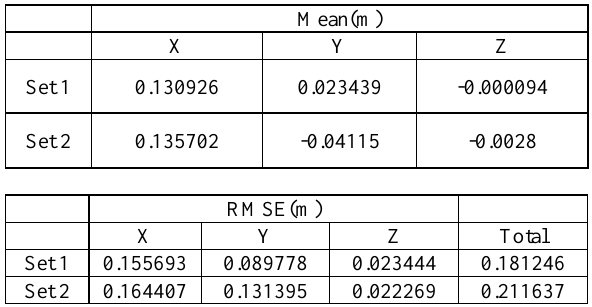
Table 3. Mean & RMSE using Bundle Adjustment